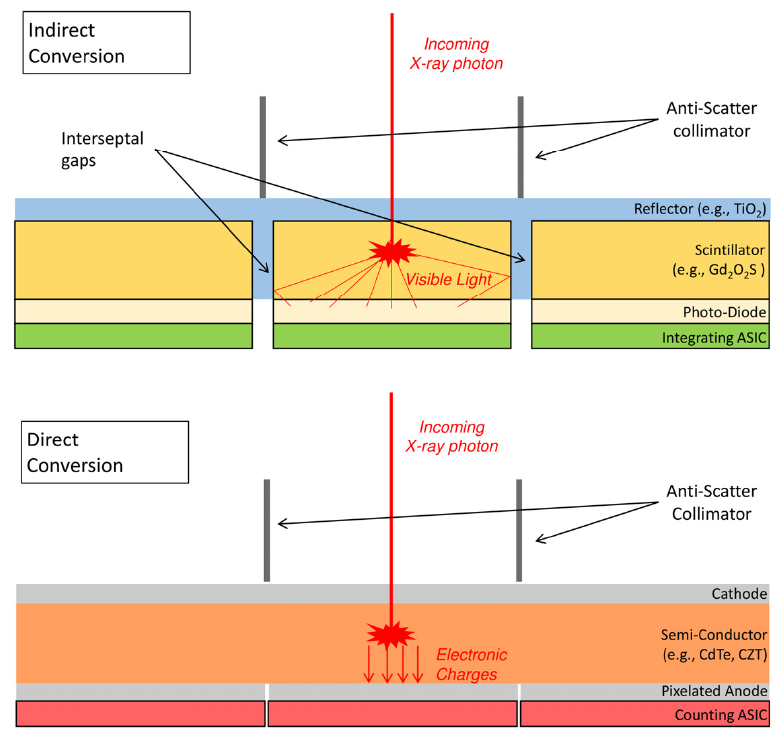
Figure 1. Schematic representation of photon detection technologies: energy-integrating ( top ) and photon-counting detectors ( bottom ).